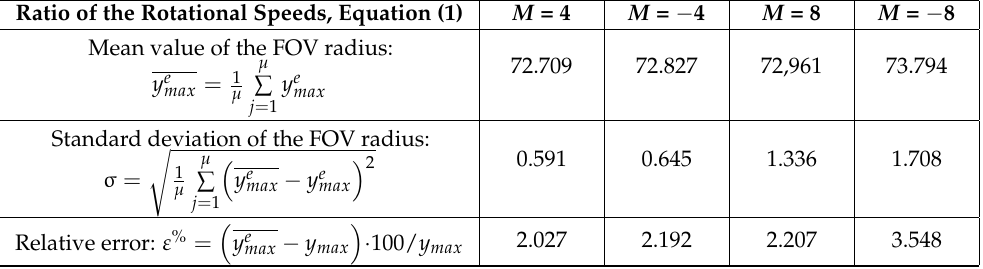
Table 3. Error analysis of the experimental ( y e max ) versus simulated ( y max ) maximum radius of the FOV/scan patterns in Figure